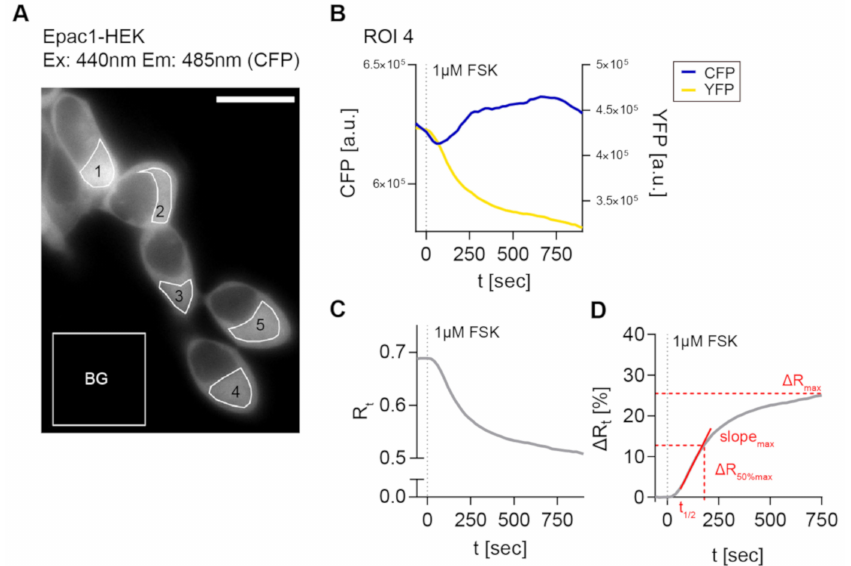
Figure 2. 3 (cid:48) ,5 (cid:48) -cyclic adenosine monophosphate-Förster resonance energy transfer (cAMP-FRET) imaging of Epac1-HEK cells and FRET data analysis. ( A ) Representative fluorescent CFP image of Epac1-HEK cells excited with 440 nm light, measured regions of interest (ROIs) and background ROI. ( B ) Individual bleedthrough-corrected time-dependent fluorescence intensity traces (blue CFP, yellow YFP) from ROI 4 in ( A ) after stimulation with 1 µ M Forskolin (FSK). ( C ) Time-dependent FRET ratio Rt (grey) calculated from fluorescence intensities in ( B ). ( D ) Normalized, time-dependent FRET ratio changes ∆ Rt calculated from ( C ) and analyzed FRET response parameters (red). Scale bar = 20 µ